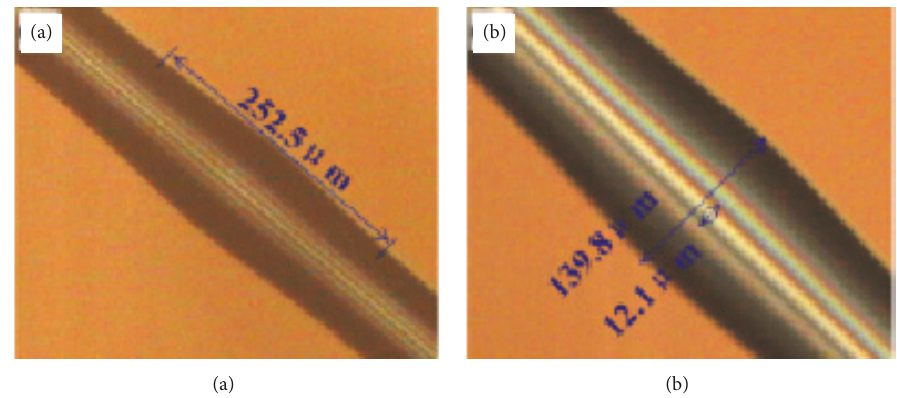
Figure 2: Microscope photograph of the sensor structure with 8x magnification.